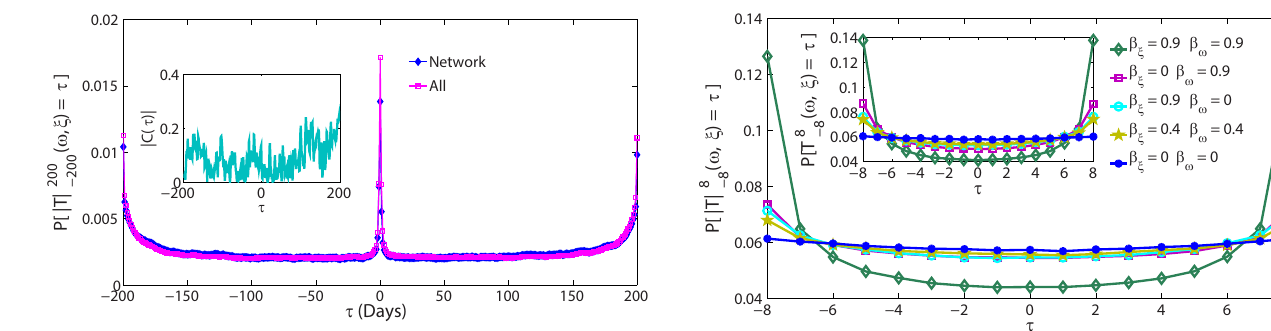
Figure 1. Distribution of links having a given | T | 200 − for (cid:127) = 365 days over all times t (Network). The climate network was constructed from temperature anomaly time series using the method and parameters outlined by Yamasaki et al. (2008) 2 , as dis- cussed in the Introduction. We also show | T | 200 − possible pairs (All) for comparison. In both cases we can see peaks at τ = ± 200 – which is the bias we are investigating in this paper – as well as an expected peak at about zero. Inset: a sample absolute cross-correlation as a function of time lag with a peak at τ = 200.